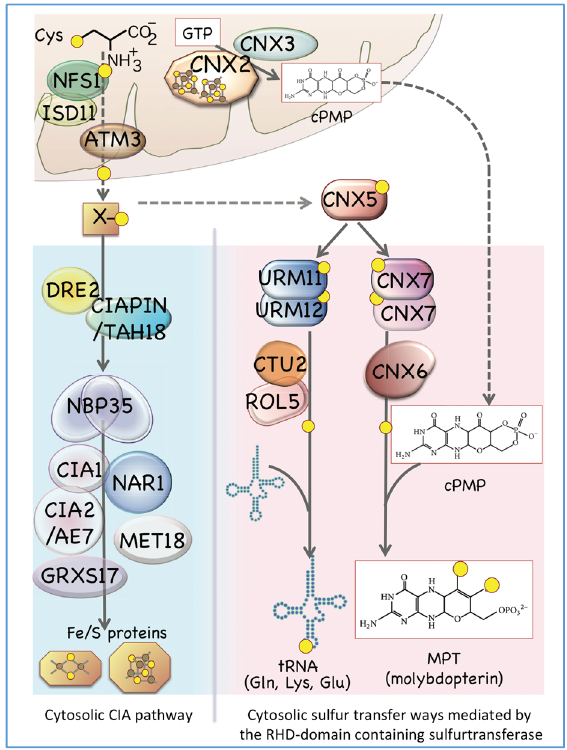
Figure 3. Two di ff erent sulfur transfer processes found in Arabidopsis cytosol. One is the cytosolic Fe / S cluster assembly pathway (CIA) pathway for the maturation of the Fe / S clusters (iron ions and sulfur atoms are indicated as brown and yellow dots, respectively) (left), and the other is the sulfur transfer pathway mediated by the rhodanese (RDH) domain-containing sulfurtransferase CNX5, which is required to the biosynthesis of molybdopterin (MPT) and sulfur-modified tRNAs (right). Arabidopsis CNX5 / STR13 is a unique sulfurtransferase consisting of a MoeB-like domain at the amino terminal region and a RHD domain at its carboxyl terminal region [67,70,71]. From the